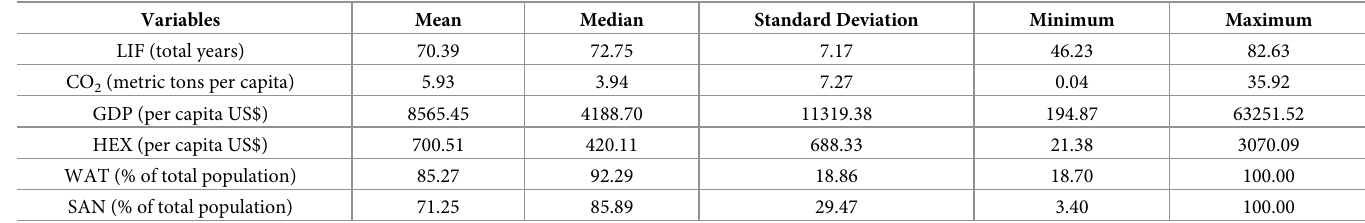
Table 1. Descriptive statistics of the